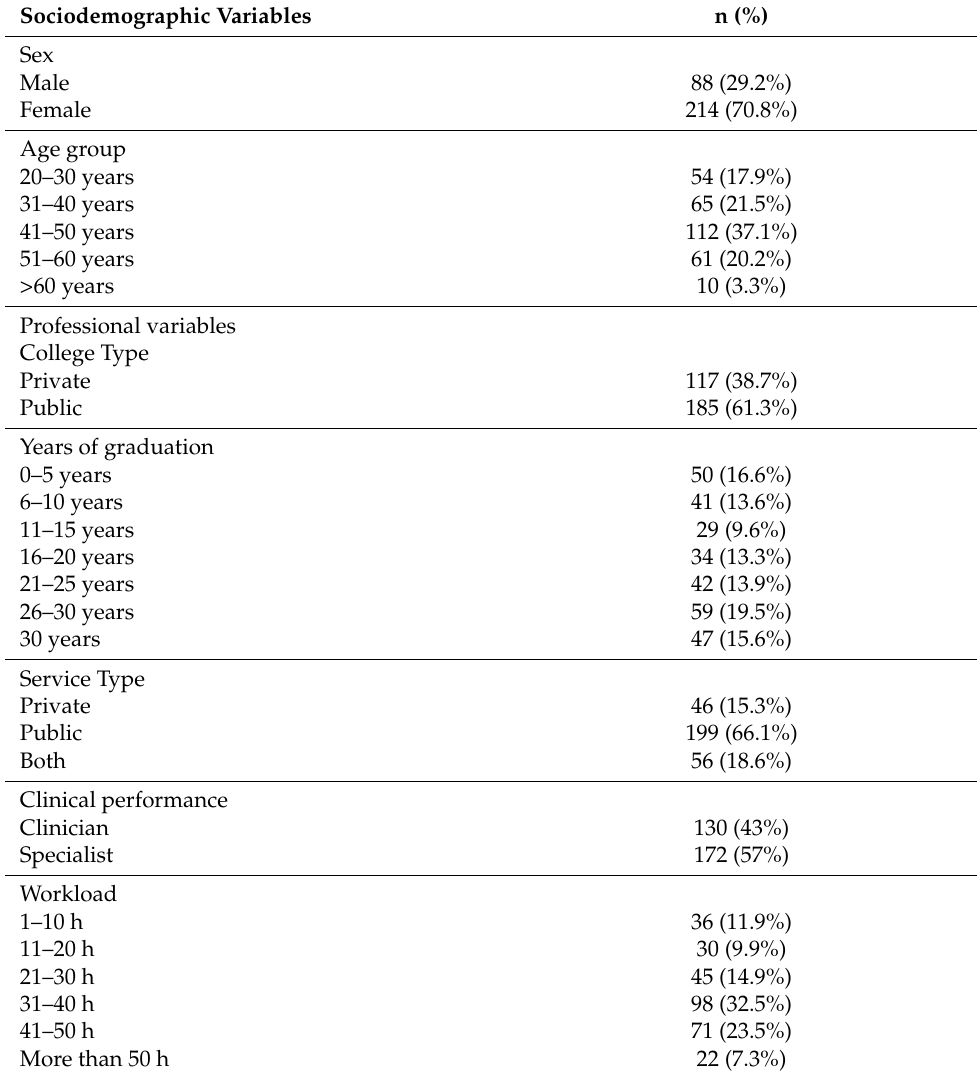
Table 1. Descriptive analysis of sociodemographic variables and professional variables.